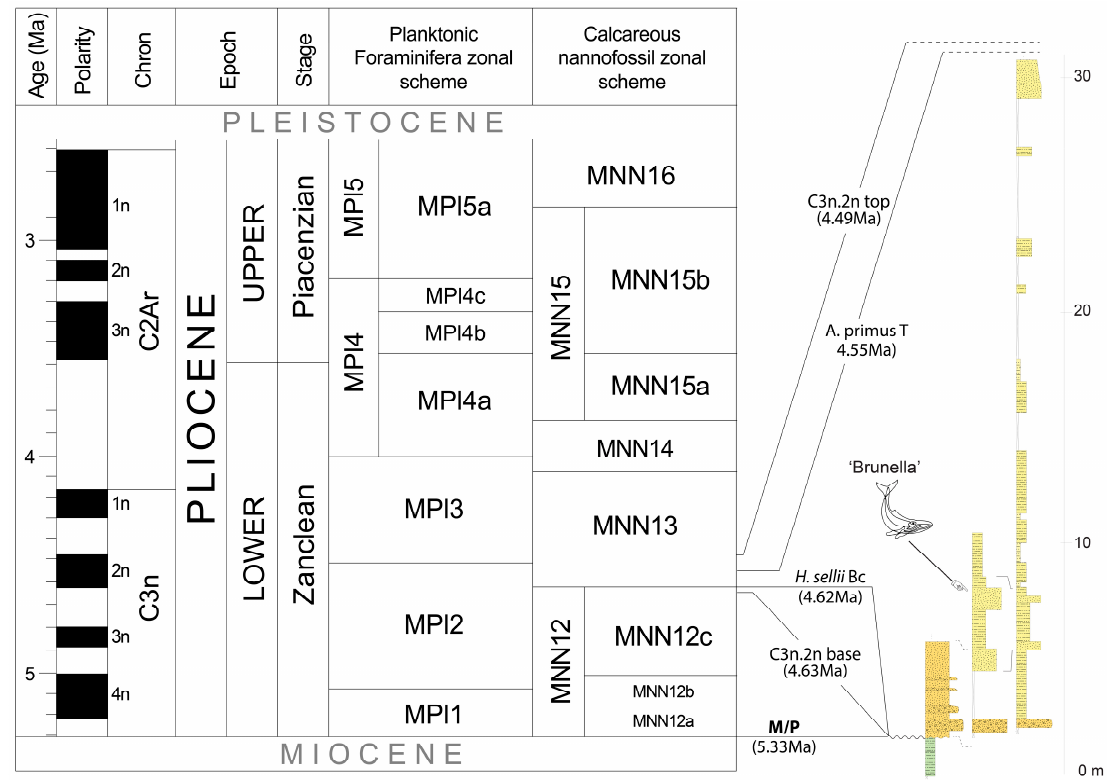
Figure 13. Bio-magneto-chronostratigraphic framework of the Brunella Composite section. Plank- tonic Foraminifera and calcareous nannofossil zonal schemes are from [70] and [62], respectively.